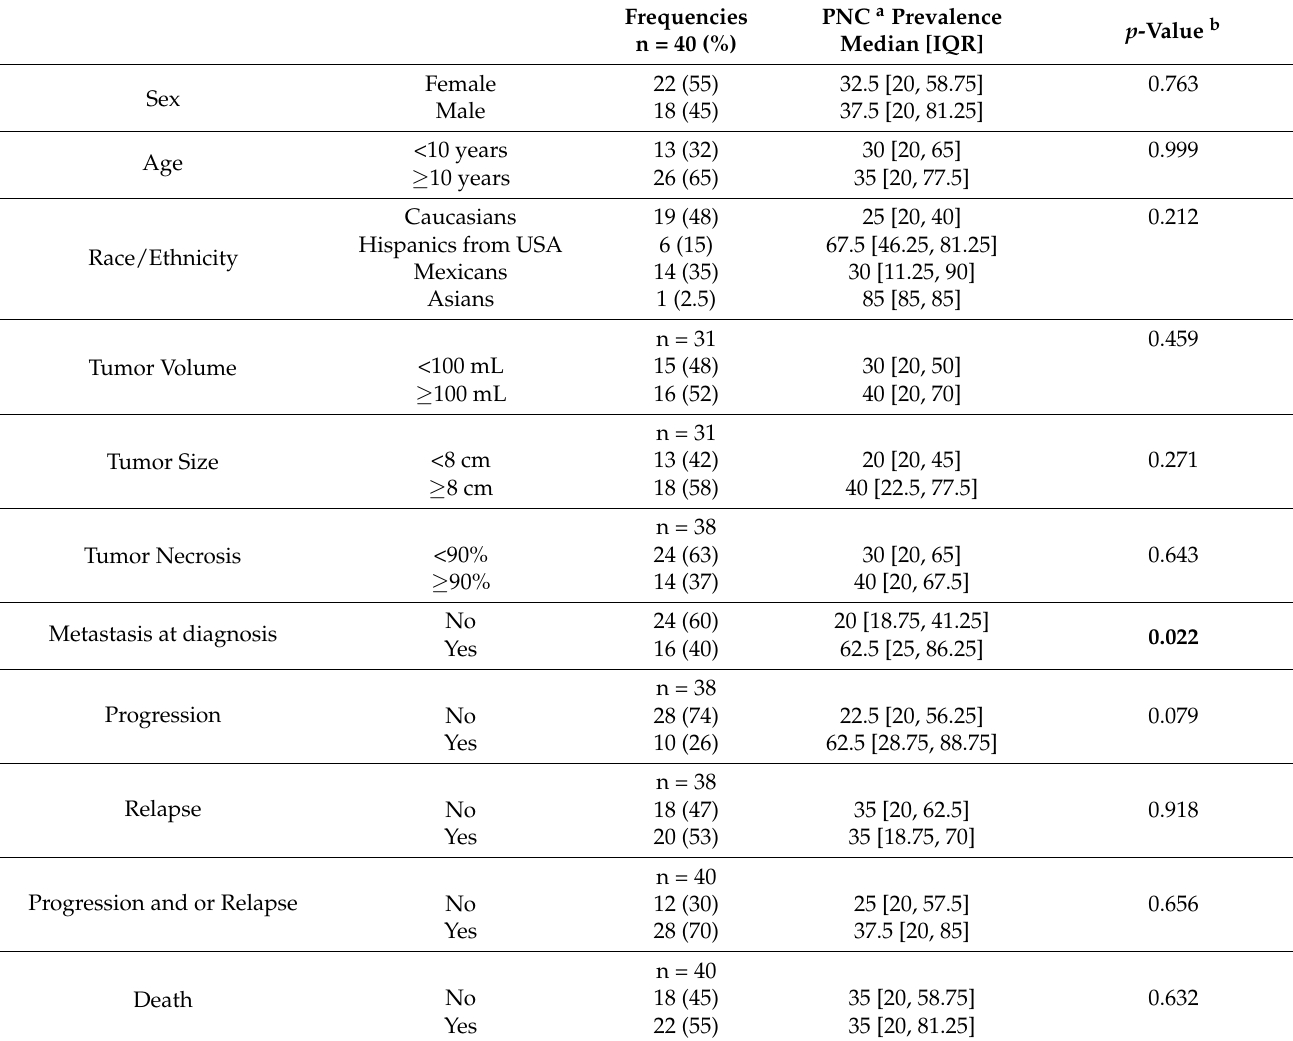
Table 1. Perinucleolar compartment and the distribution of variables in the study